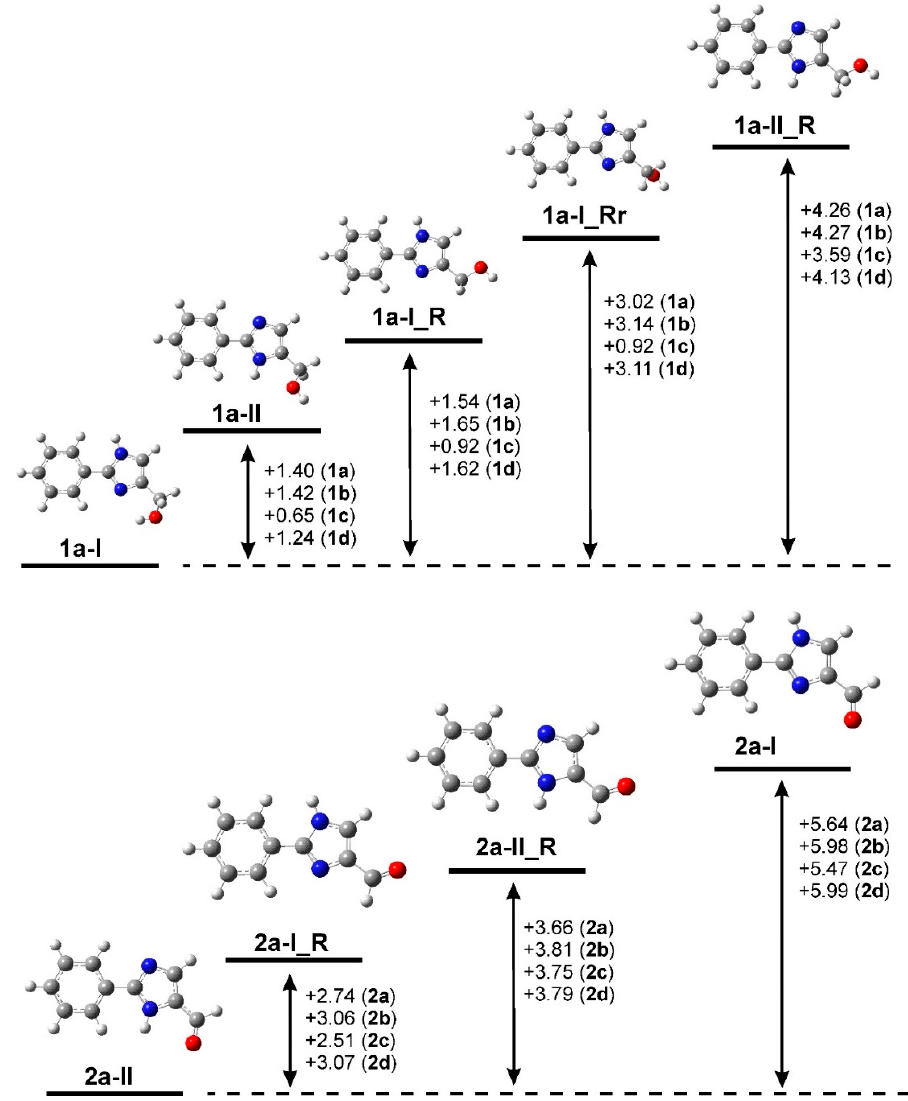
Figure 7. DFT calculated energy differences (in kcal/mol, and corrected for ZPVE) for all optimized (B3LYP-6-31G(d,p) in gas phase) geometries of the possible rotamers ( R and Rr ) and tautomers ( I and II ) of the 2-substituted imidazoles: (top) 1a – d — (2-phenyl-1 H -imidazol-4(5)-yl)methanols, structures shown for 1a only, and (bottom) 2a – d — 2-phenyl-1 H -imidazole-4(5)-carbaldehydes, structures shown for 2a only.